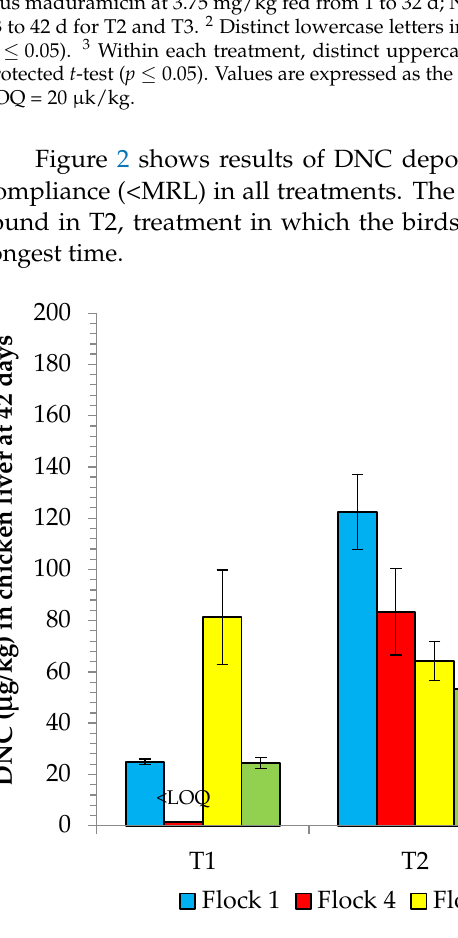
Figure 2. DNC residues in chicken liver at 42 days for all treatments (T1-T3). T1: NCZ at 125 mg/kg fed from 1 to 21 d; T2: NCZ at 125 mg/kg fed from 1 to 32 d; T3: NCZ at 40 mg/kg plus maduramicin at 3.75 mg/kg fed from 1 to 32 d; NCZ-free feed (withdrawal period): 22 to 42 d for T1; and 33 to 42 d for T2 and T3.